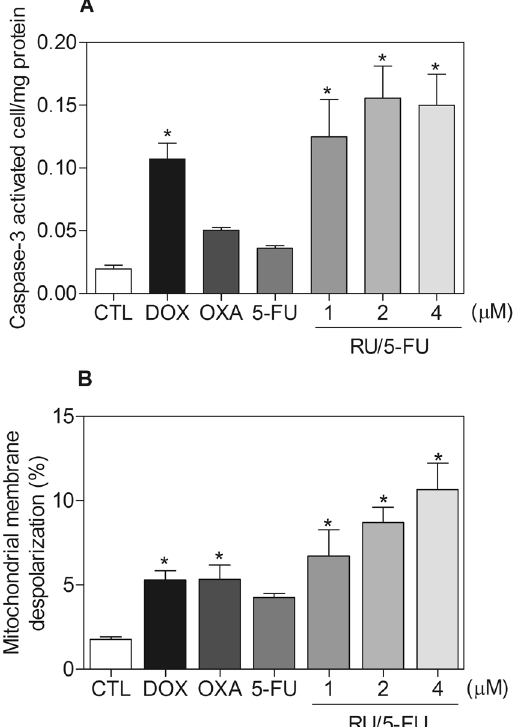
Figure 8. Effect of the complex [Ru(5-FU)(PPh 3 ) 2 (bipy)]PF 6 (RU/5-FU) in the caspase-3 activity and mitochondrial membrane potential on HCT116 cells. ( A ) Caspase-3 activity determined by colorimetric assay 48 h after incubation. ( B ) Mitochondrial membrane potential determined by flow cytometry using rhodamine 123 staining 24 h after incubation. The negative control (CTL) was treated with the vehicle (0.1% DMSO) used for diluting the compound tested. Doxorubicin (DOX, 1 µ M), oxaliplatin (OXA, 2.5 µ M) and 5-fluorouracil (5-FU, 4 µ M) were used as the positive controls. Data are presented as the mean ± S.E.M. of three independent experiments performed in duplicate. Ten thousand events were evaluated per experiment and cellular debris was omitted from the analysis. * p < 0.05 compared with the negative control by ANOVA followed by Student Newman-Keuls